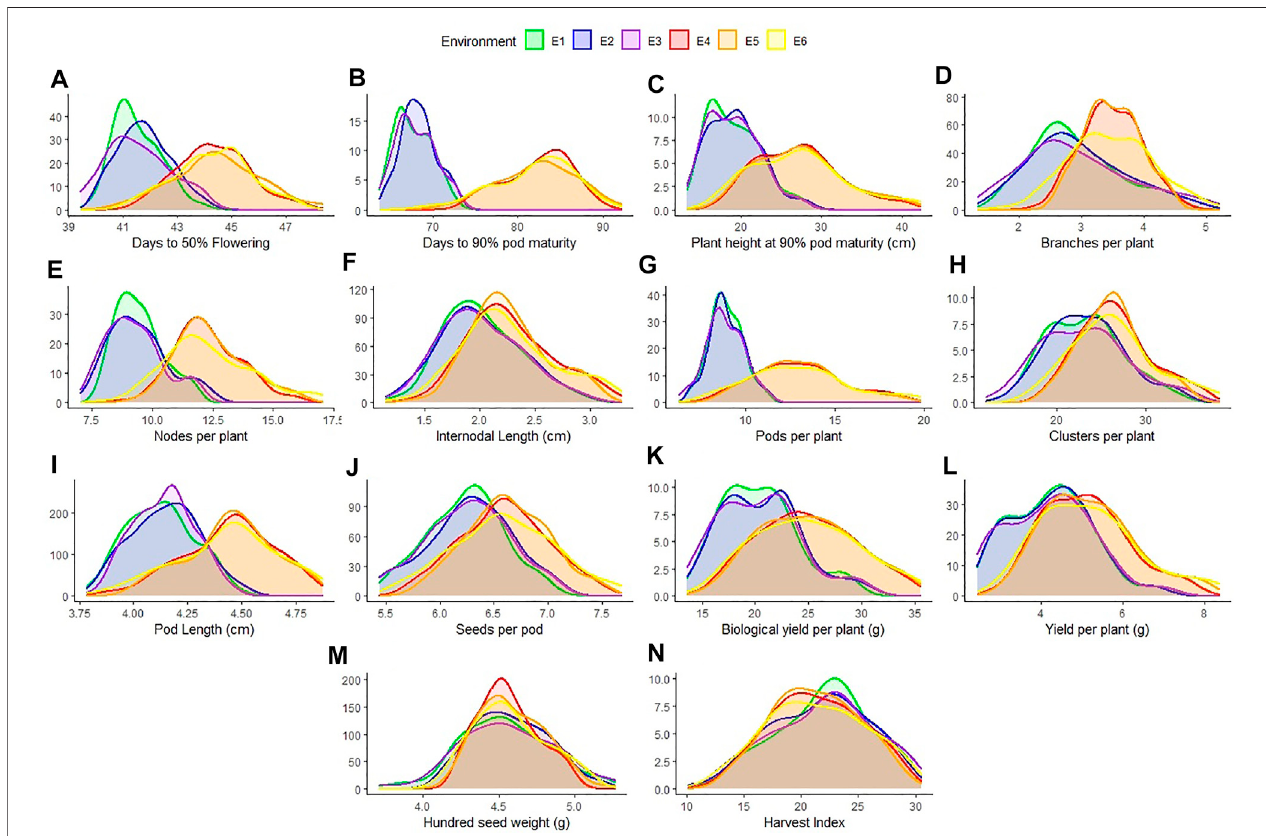
FIGURE 1 | Distribution of 14 characters measured for 100 blackgram germplasm lines across all environments- Ludhiana 2019 (E1); Ludhiana 2020 (E2); Ludhiana combined across years (E3); Gurdaspur 2019 (E4); Gurdaspur 2020 (E5) and Gurdaspur combined across years (E6).